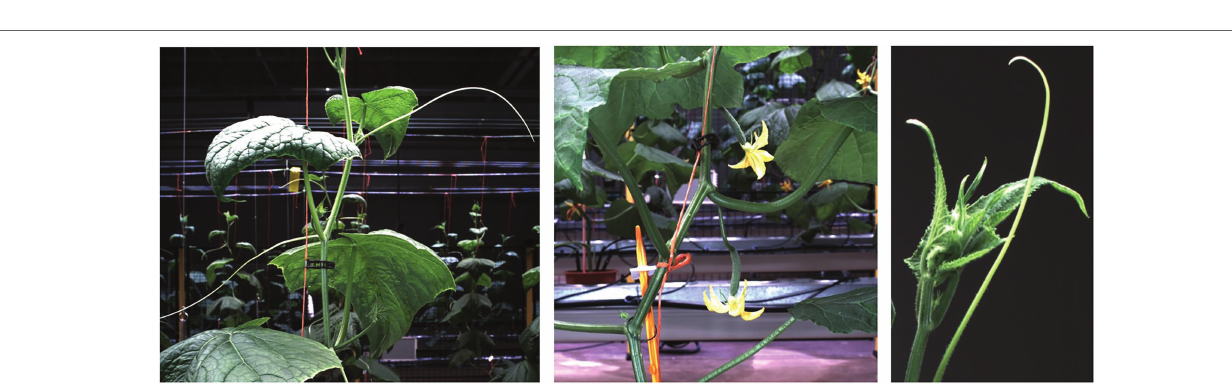
FIGURE 2 | Impression of the different parts of the cucumber plants. The left image contains leaves, stem, petioles, tendrils and the supporting wire. In the middle image, two emerging fruits with flowers, in this research classified together as “ovary,” are visible. Also, some nodes are clearly visible in this image. The right image shows the growing point of the plant and another